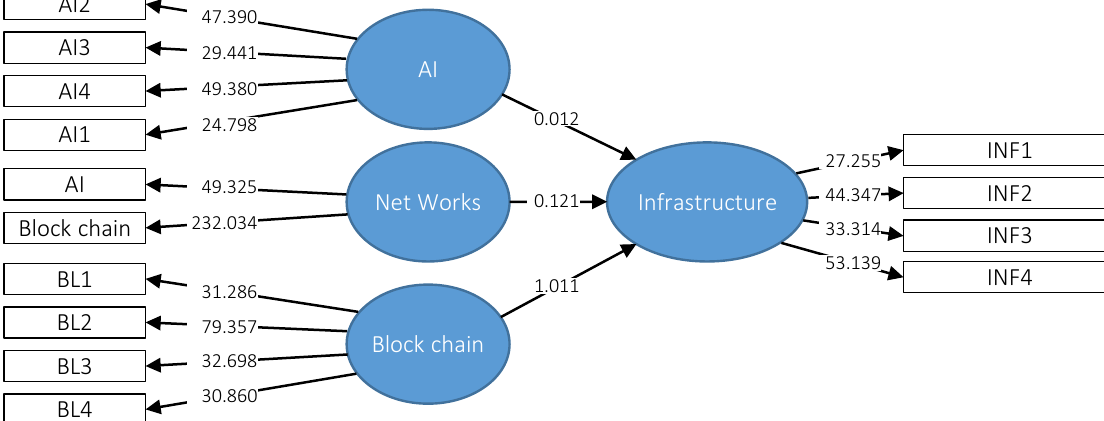
Figure 5. Employing network strategic capabilities on